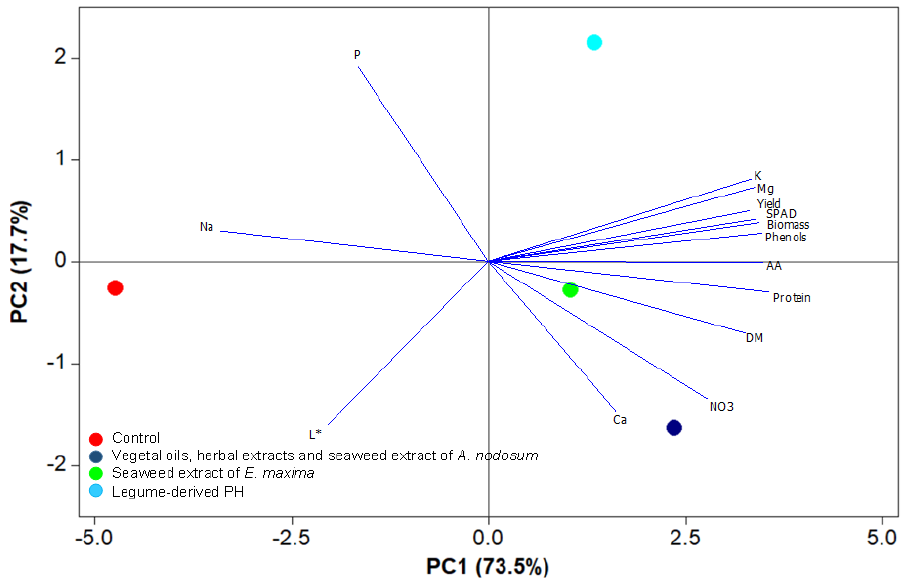
Figure 5. Principal component loading plot and scores of principal component analysis (PCA) of morphometric and quality traits of greenhouse spinach in response to four biostimulant treatments. AA, total ascorbic acid; DM, leaf dry matter percentage.